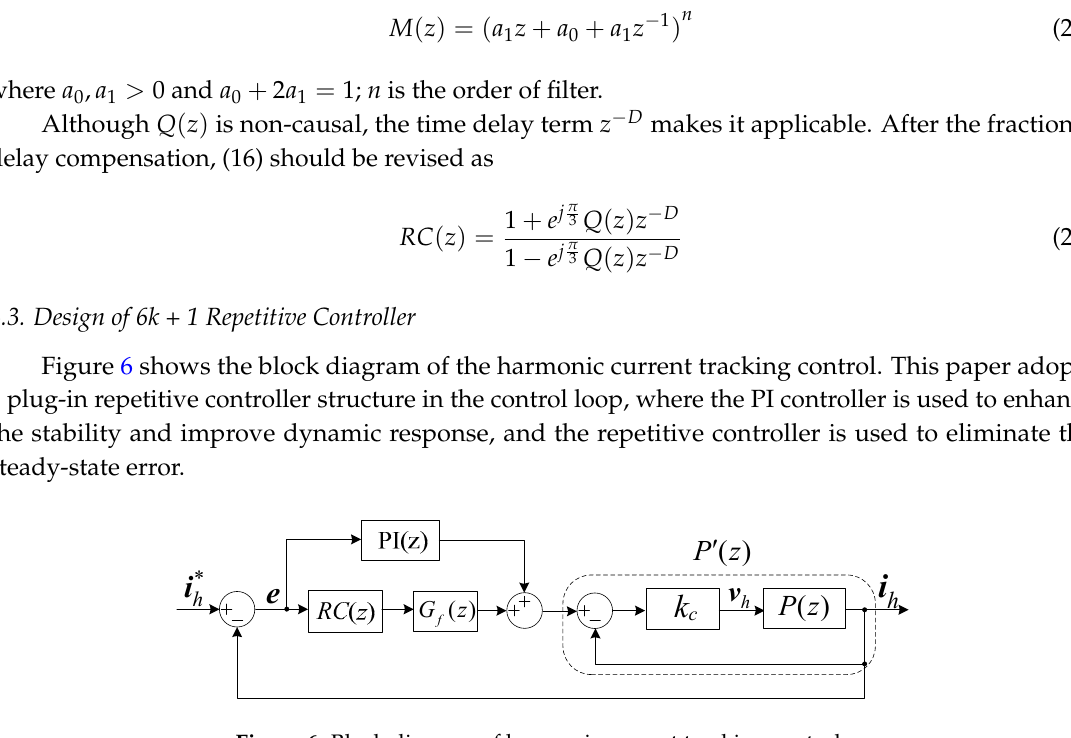
Figure 6. Block diagram of harmonic current tracking control.